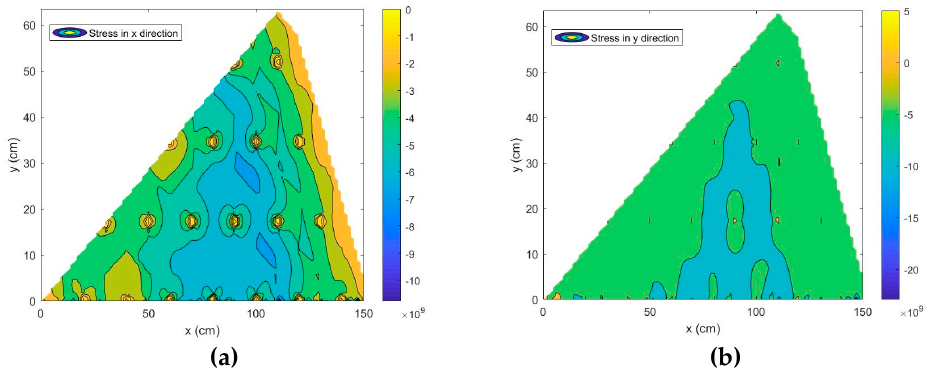
Energies 2023 , 16 , x FOR PEER REVIEW Figure 16. Node displacement of 1/12 core (( a ) X direction and ( b ) Y direction). Figure 16. Node displacement of 1/12 core (( a ) x direction and ( b ) y direction).